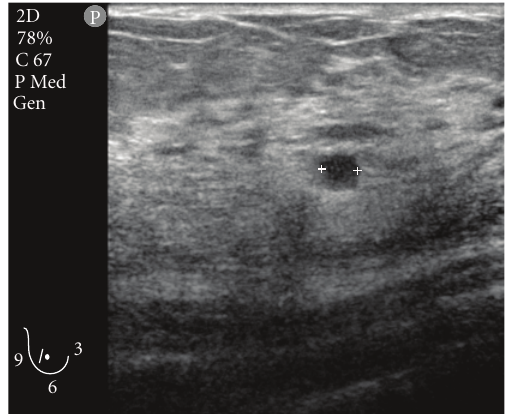
Figure 1: Hypoechoic lesion with demarcated margins and weak echo enhancement.